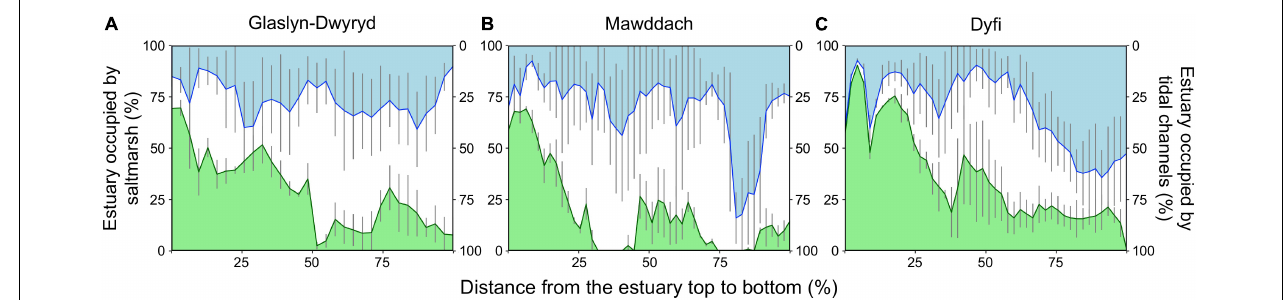
FIGURE 6 | The mean percentage of estuarine widths occupied by salt marsh (green) and tidal channel (blue) between 1946 and 2013, as recorded at intervals of 200 m (expressed as a percentage) from the top (left) to the bottom (right) of the (A) Glaslyn-Dwyryd, (B) Mawddach, and (C) Dyfi estuaries. Estuary widths (y-axis) and lengths (x-axis) are expressed in percent to standardize across variation in estuarine size. Space between marsh and channel lines represents the portion occupied by mudflat. Vertical error bars represent standard deviation in marsh extent.